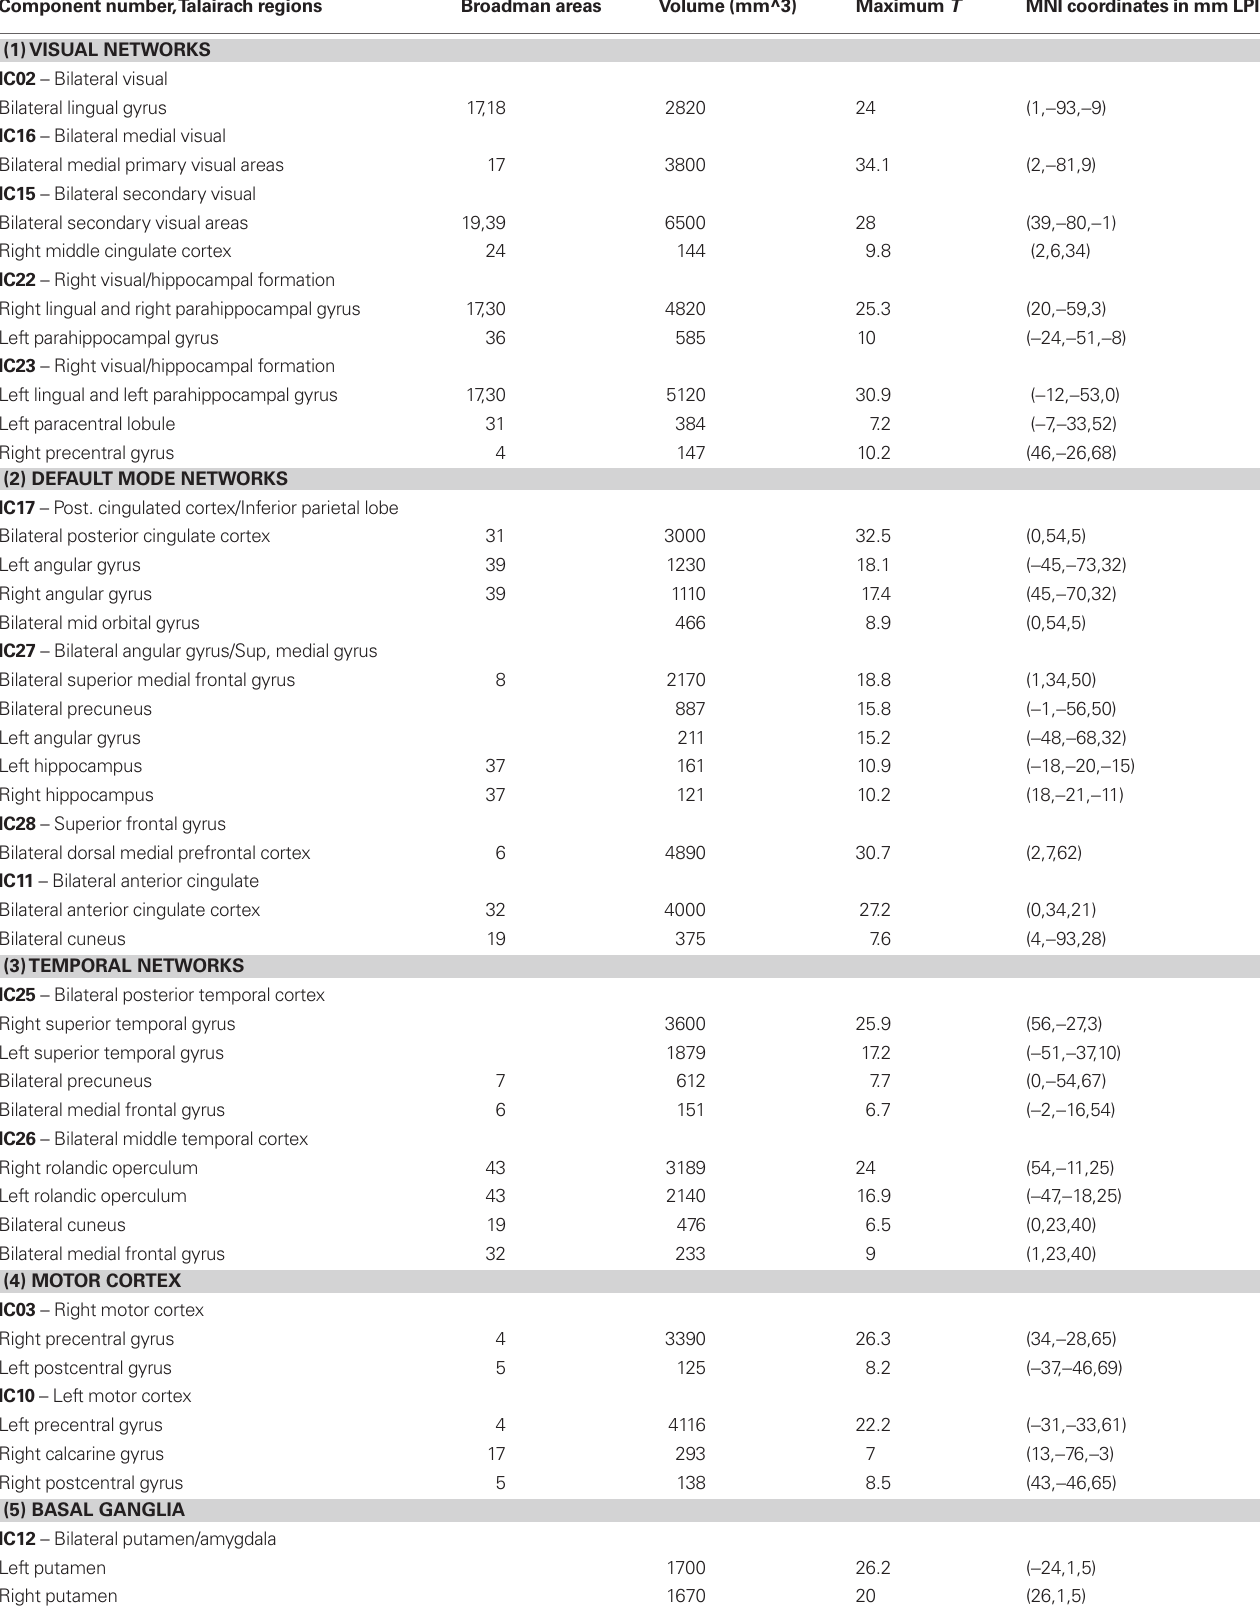
Table 1 | resting-state networks obtained from group iCA. Clusters of at least 120 voxels at a threshold t > 5 are reported. Component number, Talairach regions Broadman